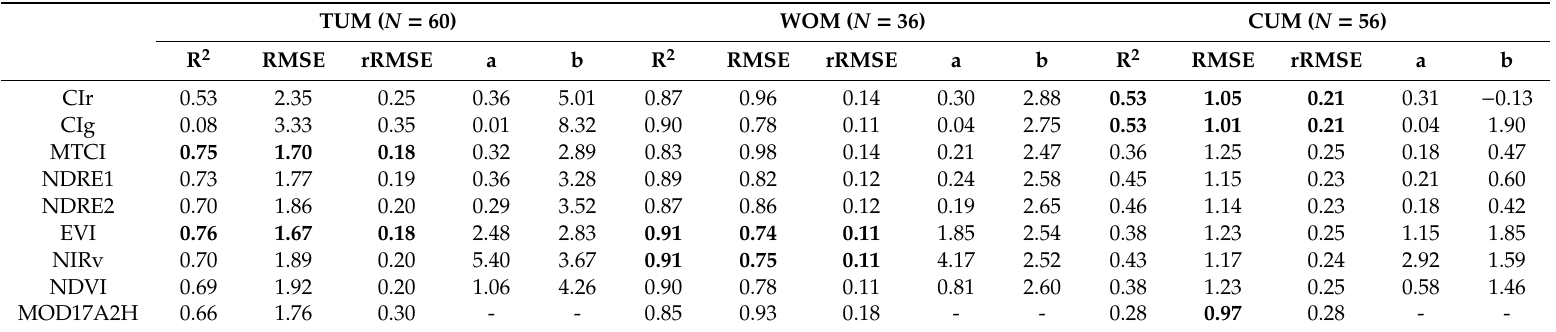
Table 3. The algorithm results for 16-day average daytime gross primary productivity (GPP) estimated at evergreen broadleaf forest (EBF) sites, with the determination coe ffi cient ( R 2 ), root-mean-square error (RMSE; unit in gC · m − 2 · day − 1 ), and relative RMSE (rRMSE) presented. We employed the equation GPP EC = a × VI × PAR + b here, where the vegetation index (VI) is the rebuilt time series, and PAR is the photosynthetic active radiation. The number of samples at each site is presented in parentheses after the site name. The numbers in bold represent the highest R 2 , lowest RMSE, and lowest rRMSE values. TUM ( N = 60) WOM ( N = 36) CUM ( N = 56) R 2 RMSE